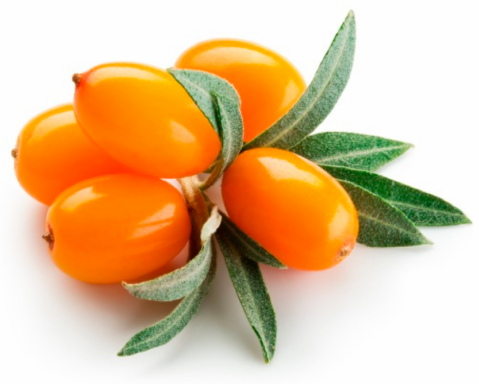
Figure 1. Sea buckthorn fruit